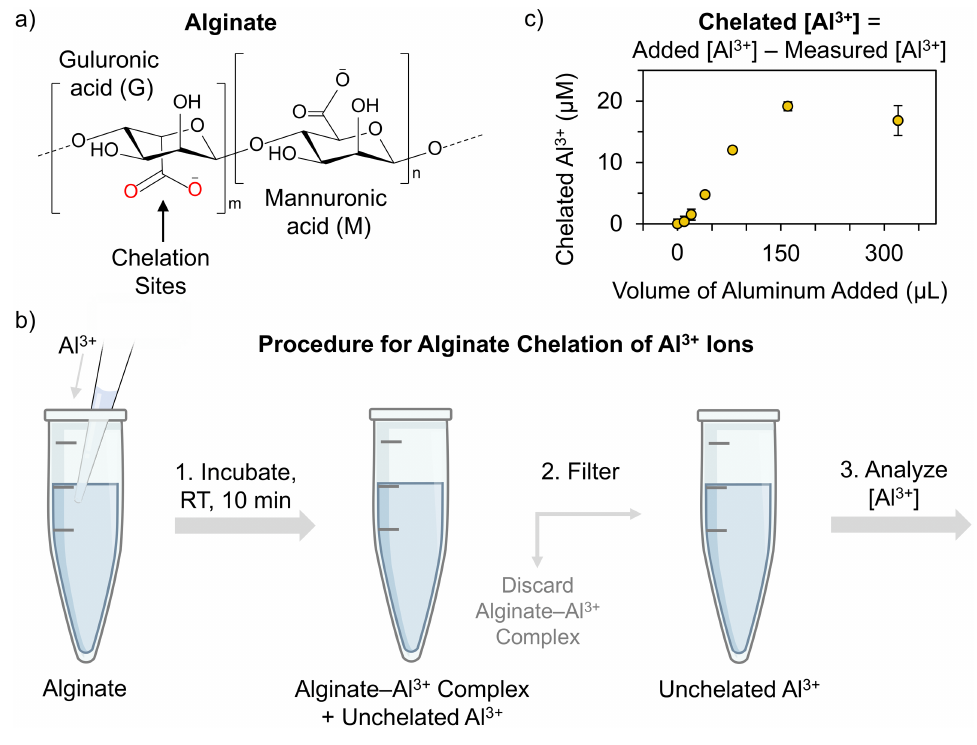
Figure 5 Measuring sodium alginate chelation of aluminum via the rutin-based colorimetric assay. Representation of the alginate chelation response to Al 3 + ions. (A) Chemical structure of the sodium algi- nate polymer consisting of (1,4)-linked β -D-mannuronate (M) and α -L-guluronate (G) residues. The G residues participate in chelation, where the carboxylic acid moiety (highlighted in red) is the site of chela- tion. (B) Representation of the experimental design of the alginate–Al 3 + chelation process. (C) Chelation curve of the alginate complexation of Al 3 + ions that was measured using the aluminum colorimetric as- say. Note that the values in (C) are the average of n = 3 measurements and the error bars are the standard deviation of n = 3 measurements. Error bars are included for all the values in (C), but in cases where the standard deviation for the measurements is low, the error bars are not visible. Full-size DOI: